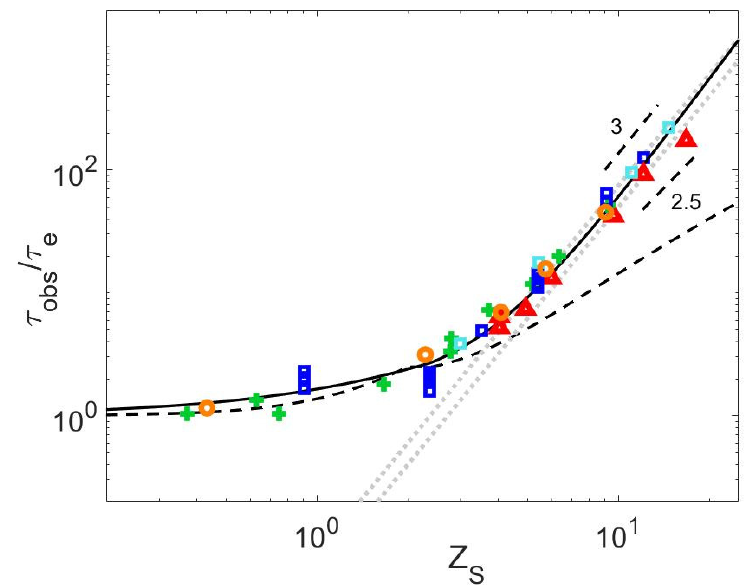
Figure 6. Normalized τ obs data versus Z S for all available datasets for PS (green +), PI (red ∆ ), PMMA (orange ), and PBD (blue ), compared to Equations (4) (black continuous line) and (5) (black dashed line) and the scaling τ obs / τ e = K W Z 3 (grey dotted S